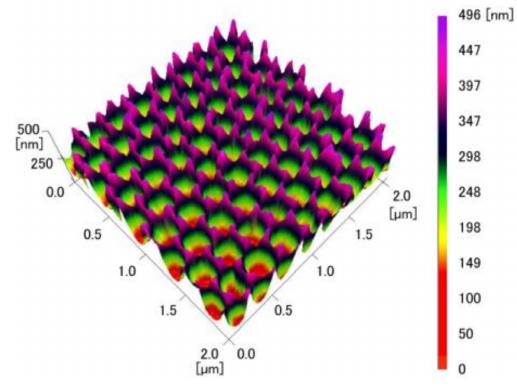
Figure 6. AFM image of the inverted moth-eye structure made of